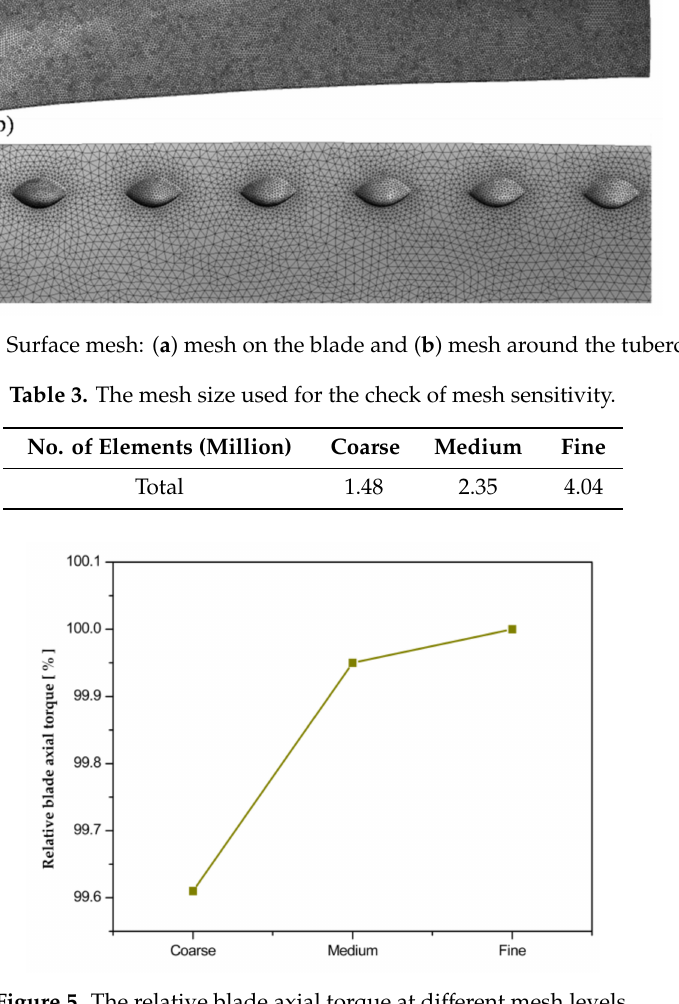
Figure 5. The relative blade axial torque at di ff erent mesh